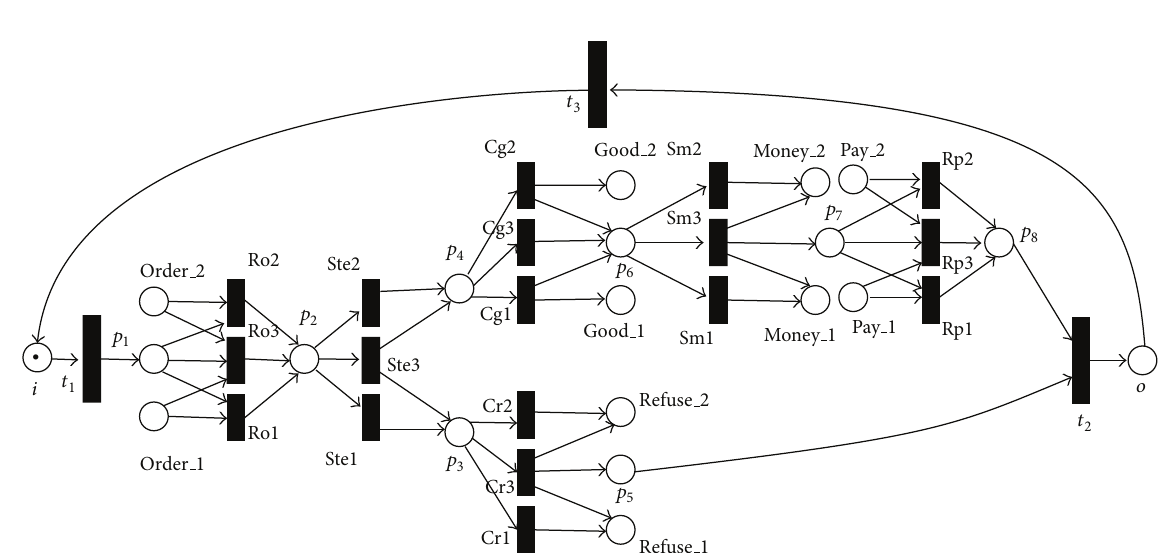
Figure 3: The LPWN 𝑁 1 is transformed into its equivalent